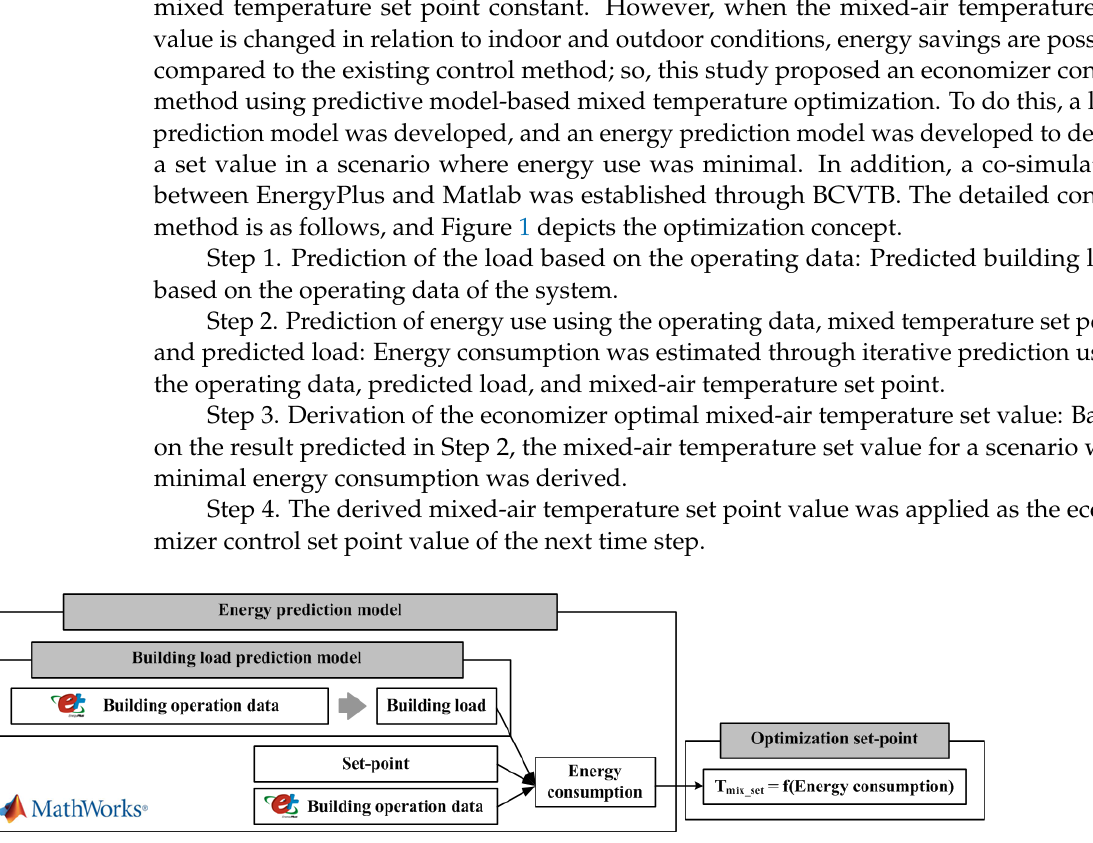
Figure 1. Schematic of the mixed temperature optimization process .